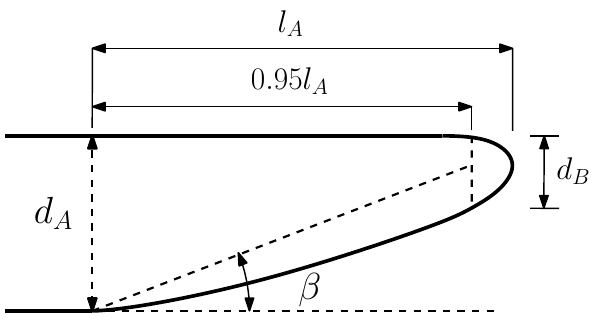
Figure 1. The definition of afterbody design parameters.